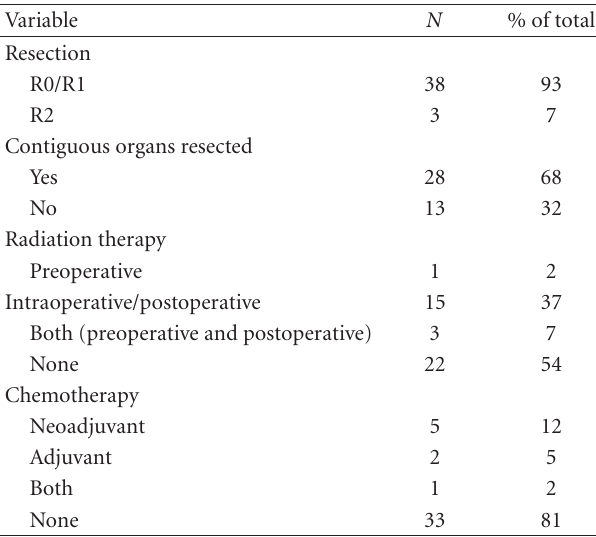
Table 2: Initial treatment characteristics of 41 patients with primary retroperitoneal sarcoma who underwent surgical resection at Stanford Hospital from 1996 to 2007.